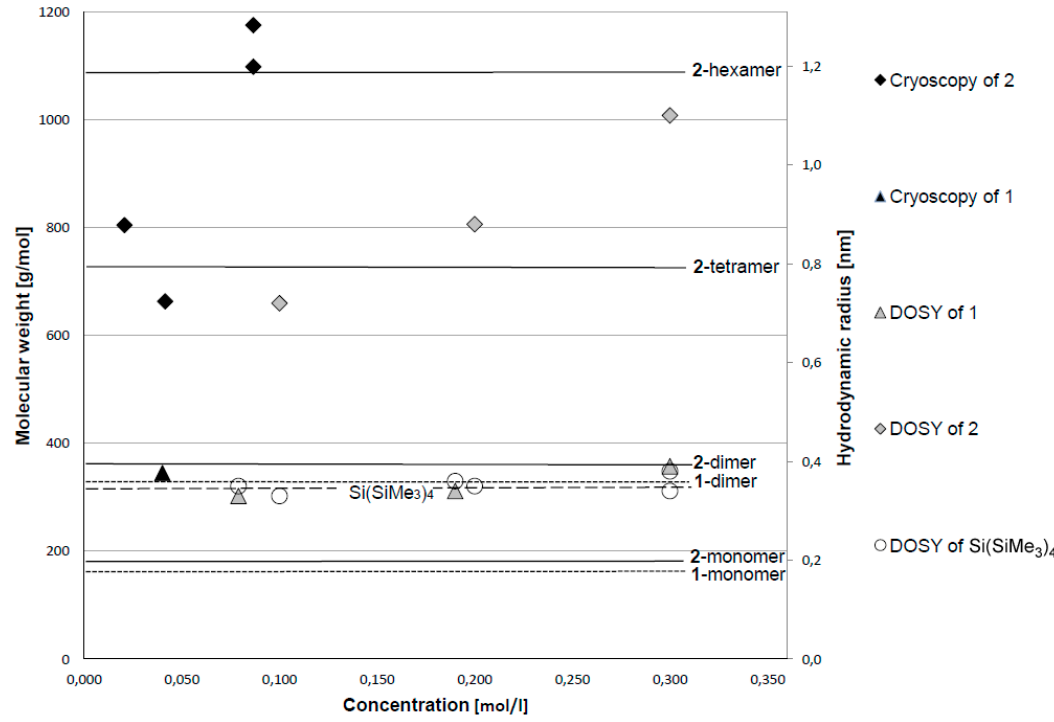
Figure 2. Graphical representation of the results of cryoscopic (at 6 °C) and NMR DOSY measurements (at 21 °C). Values for cryoscopic measurements in [g/mol] for the molecular weight ( left ordinate); the molecular weights of monomers/oligomers of 1 , 2 , and Si(SiMe 3 ) 4 are represented as horizontal lines (1: dotted line; 2: solid line; Si(SiMe 3 ) 4 , only monomeric: dashed line). Values for NMR DOSY measurements in [nm] for the hydrodynamic radius ( right ordinate). Results for compound 1 shown as triangles (full: cryoscopy; open: DOSY); for compound 2 shown as diamonds (full: cryoscopy; open: DOSY). Values for DOSY measurements of reference compound Si(SiMe 3 ) 4 are added as open circles; the right ordinate is scaled to fit the corresponding hydrodynamic radius of 0.35 nm to the height of the molecular weight of Si(SiMe 3 ) 4 with 320.84 g/mol.